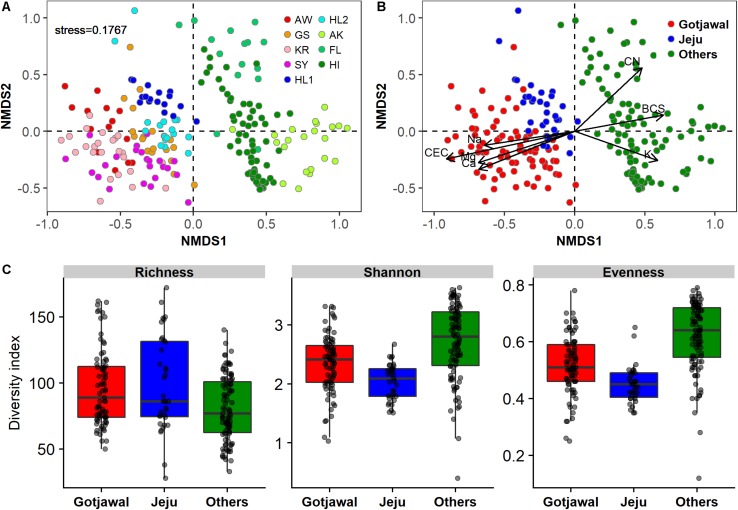
Non-metric multidimensional scaling (NMDS) plot showing the nifH-harboring communities present in this study (k = 2; stress = 0.1767). (A) Individual sampling points, (B) four regions (AW, KR, GS, and SY) of Gotjawal: Gotjawal, Non-Gotjawal forest on Jeju Island (Jeju), and other regions (Others). (C) Microbial diversity of three regions. The soil properties indicated by arrows in (B) are the significant properties (p < 0.05) contributing to each ordination.